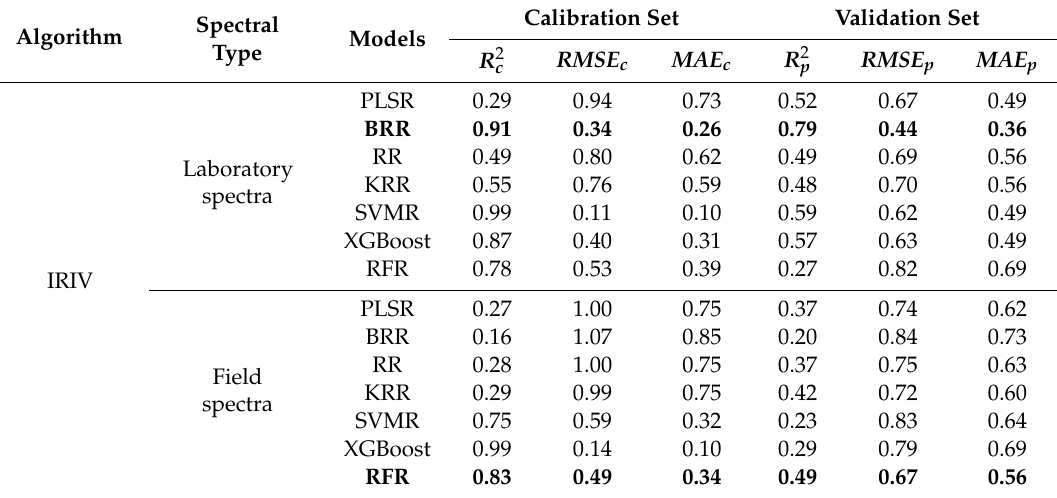
Table 4. Prediction accuracies of the As concentration obtained using laboratory spectra and field spectra based on IRIV.